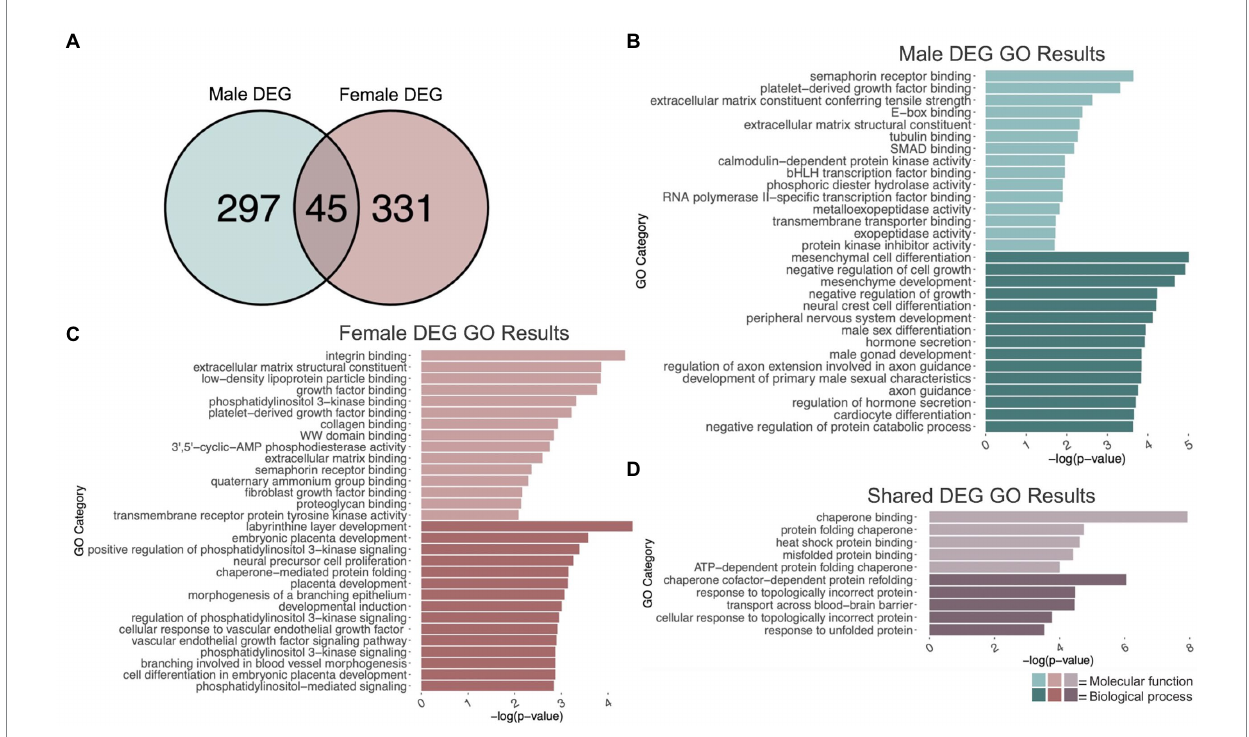
FIGURE 2 GO analysis of DEGs. (A) Number of genes differentially expressed due to adolescent binge ethanol in males and females at p < 0.01. Fisher’s exact test determined male and female gene overlap to be significant, p = 5.7e-34. (B) GO analysis of DEGs unique to males. (C) GO analysis of DEGs unique to females. (D) GO analysis of DEGs that are shared between males and